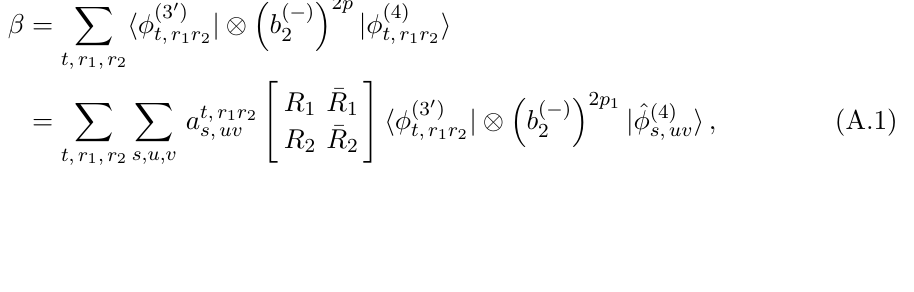
Figure 18 . Figure showing the construction of the state oppositely oriented compared to the boundaries labeled j (where j = 3 , 4 , 5) and can be glued together resulting in a two boundary